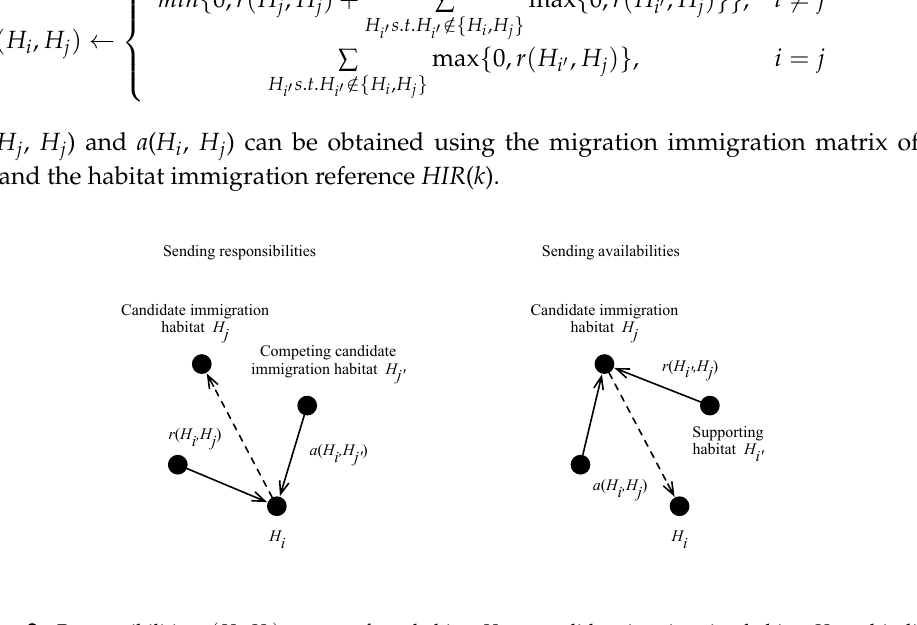
Figure 2. Responsibilities r ( H i , H j ) are sent from habitat H i to candidate immigration habitat H j and